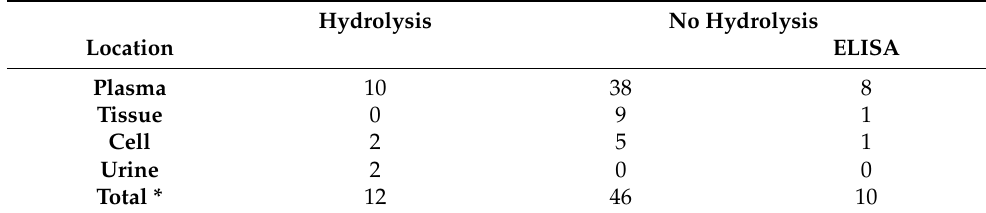
Table 1. Summary of 2020 oxylipin